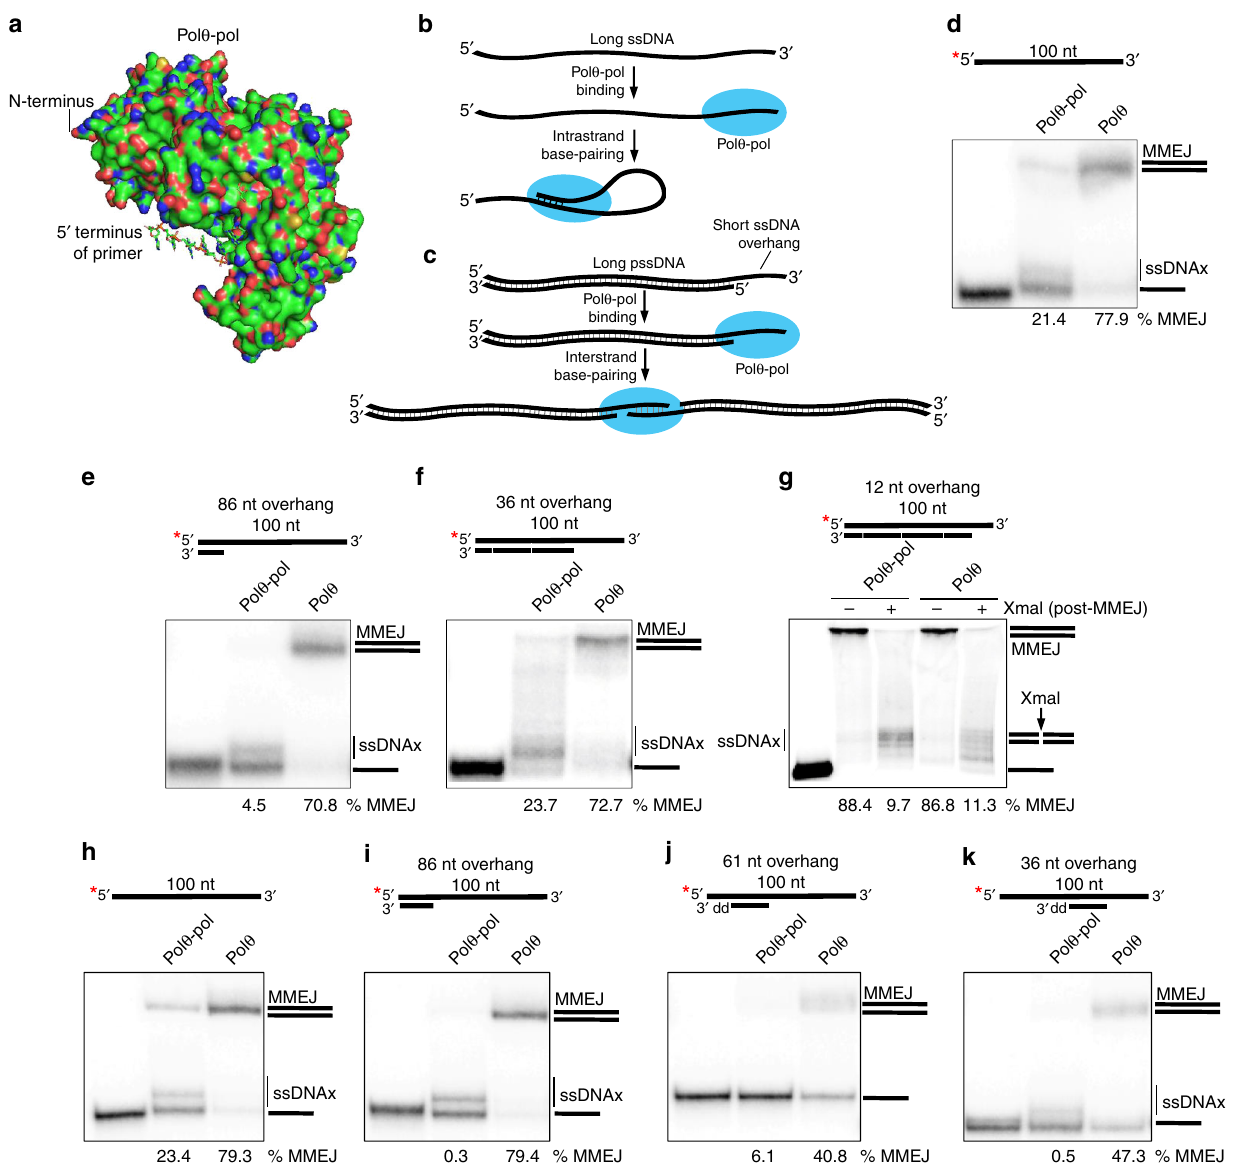
Fig. 3 Preventing intrastrand base-pairing stimulates Pol θ -pol MMEJ. a Structure of Pol θ -pol containing the primer strand. PDB, 4 × 0Q 16 . b , c Schematic of Pol θ -pol intrastrand ( b ) and interstrand ( c ) pairing. d – k Non-denaturing gels showing MMEJ reactions performed with 3 nM of indicated proteins and 10 nM of indicated DNA templates. Lanes 3 and 5 in g were treated with XmaI. % MMEJ is indicated. 3 ’ dd, 2 ’ 3 ’ -dideoxycytosine monophosphate. *, 32